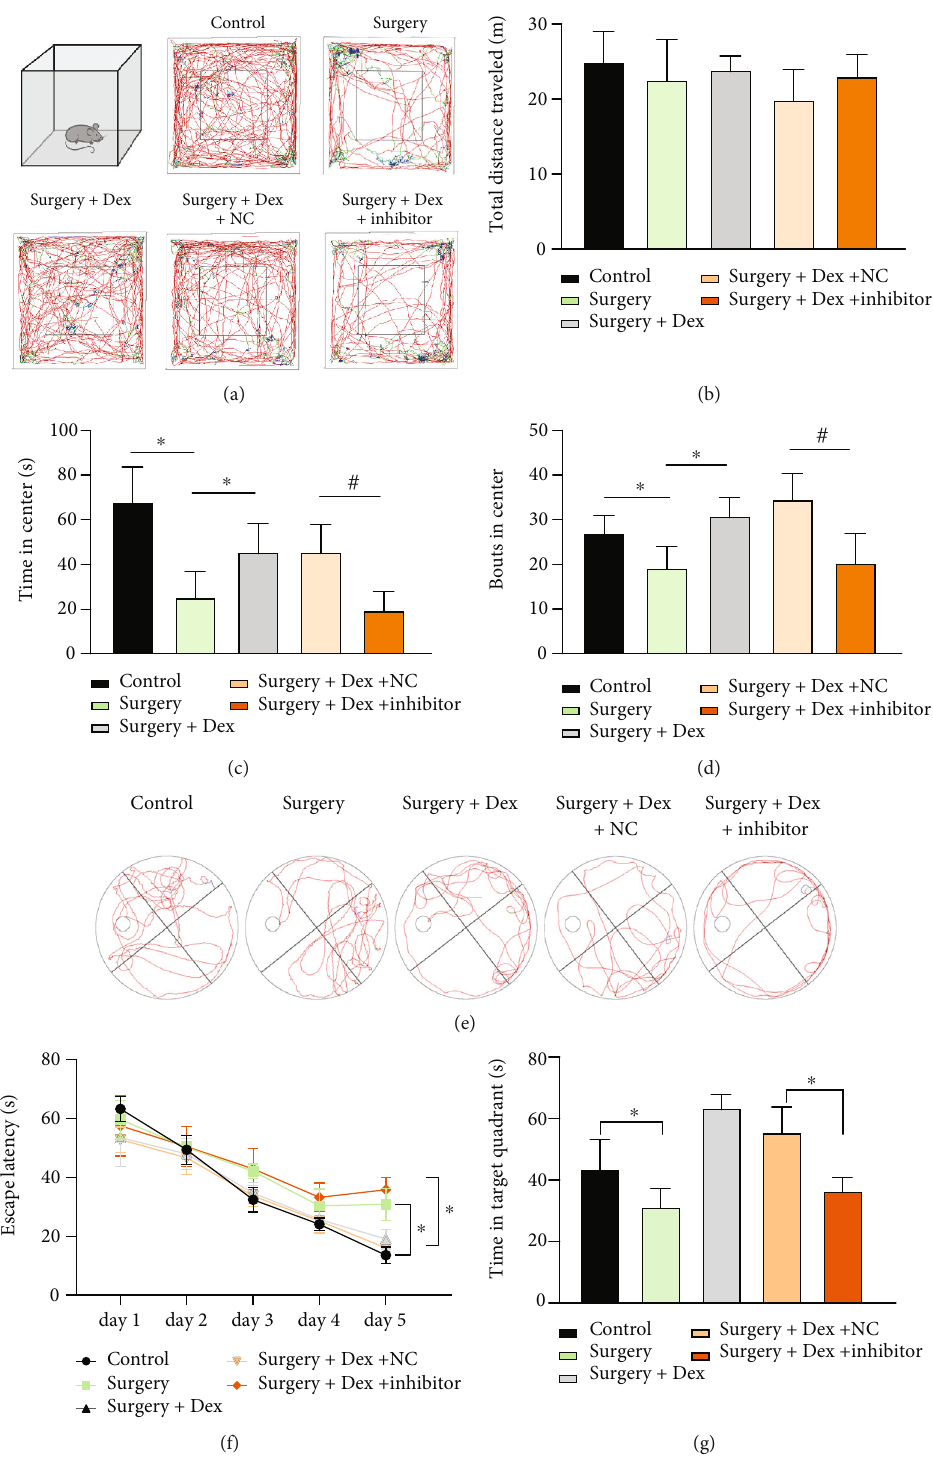
Figure 7: Changes in rat behavior following surgical trauma. ((a) – (d)) Open- fi eld tests. Rats were treated as described in Figure 6 and then subjected to open- fi eld tests. (a) Typical animal routes are shown. The total distance traveled (b), the time spent in the center (c), and bout time in the center (d) were analyzed. ((e) – (g)) Morris water maze tests. Postoperative rats were subjected to water maze tests for fi ve days. The swimming path was recorded and typical images are shown (e). Escape latency was calculated each day (f) and the time spent in the target quadrant was calculated for each group (g). (Sham as control, 3 animals for each group, n =3 repeated experiments). ANOVA (f) and two tailed t -test, ∗ , # p < 0 : 05